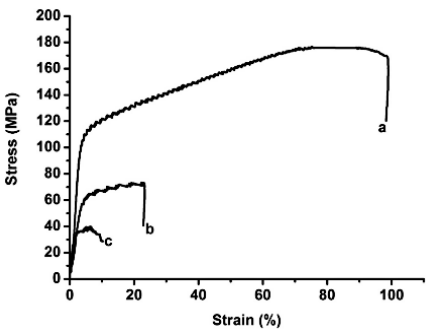
Figure 4. Compression tests on silver samples sintered by spark plasma sintering (SPS) at a low pressure (3 MPa), for a short dwell time (1 min), at a 300 °C, b 200 °C and c 150 °C. Reproduced with permission from [36].